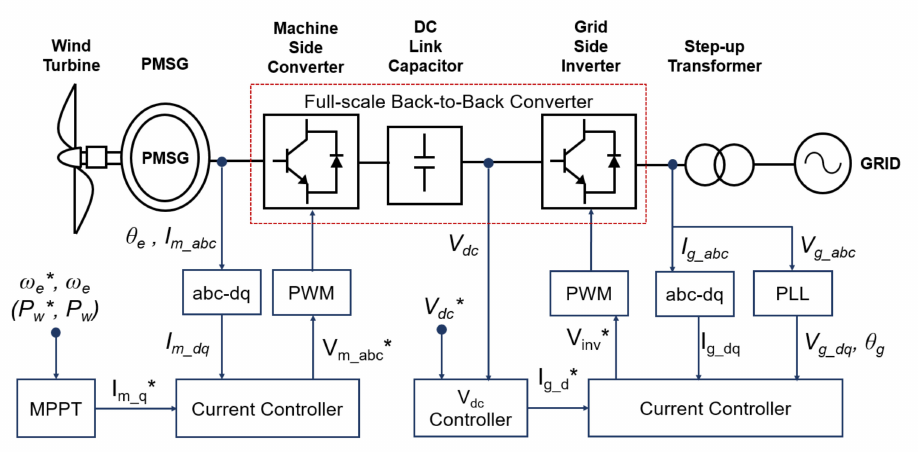
Figure 5. Simplified block diagram and control of wind turbine (WT) system.